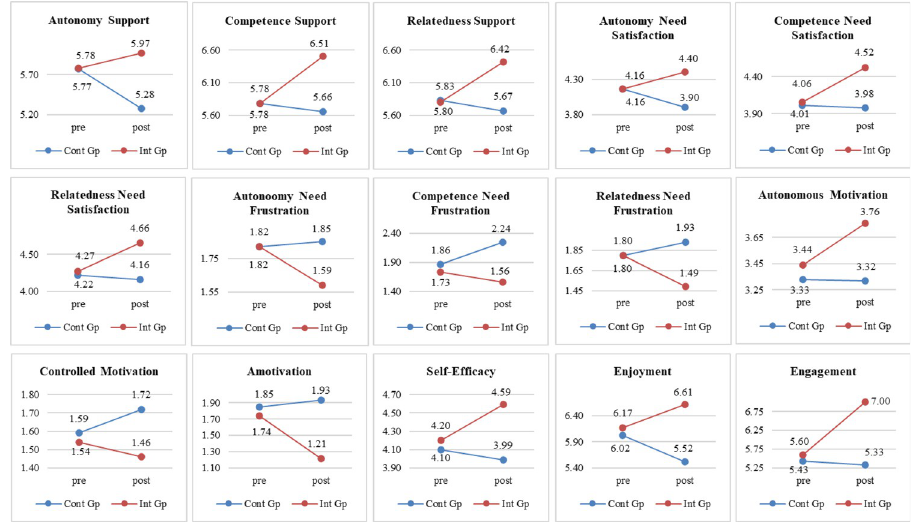
Fig 1. Scores for control group and intervention group on pre-test and post-test. (Cont Gp–Control group; Int Gp– Intervention